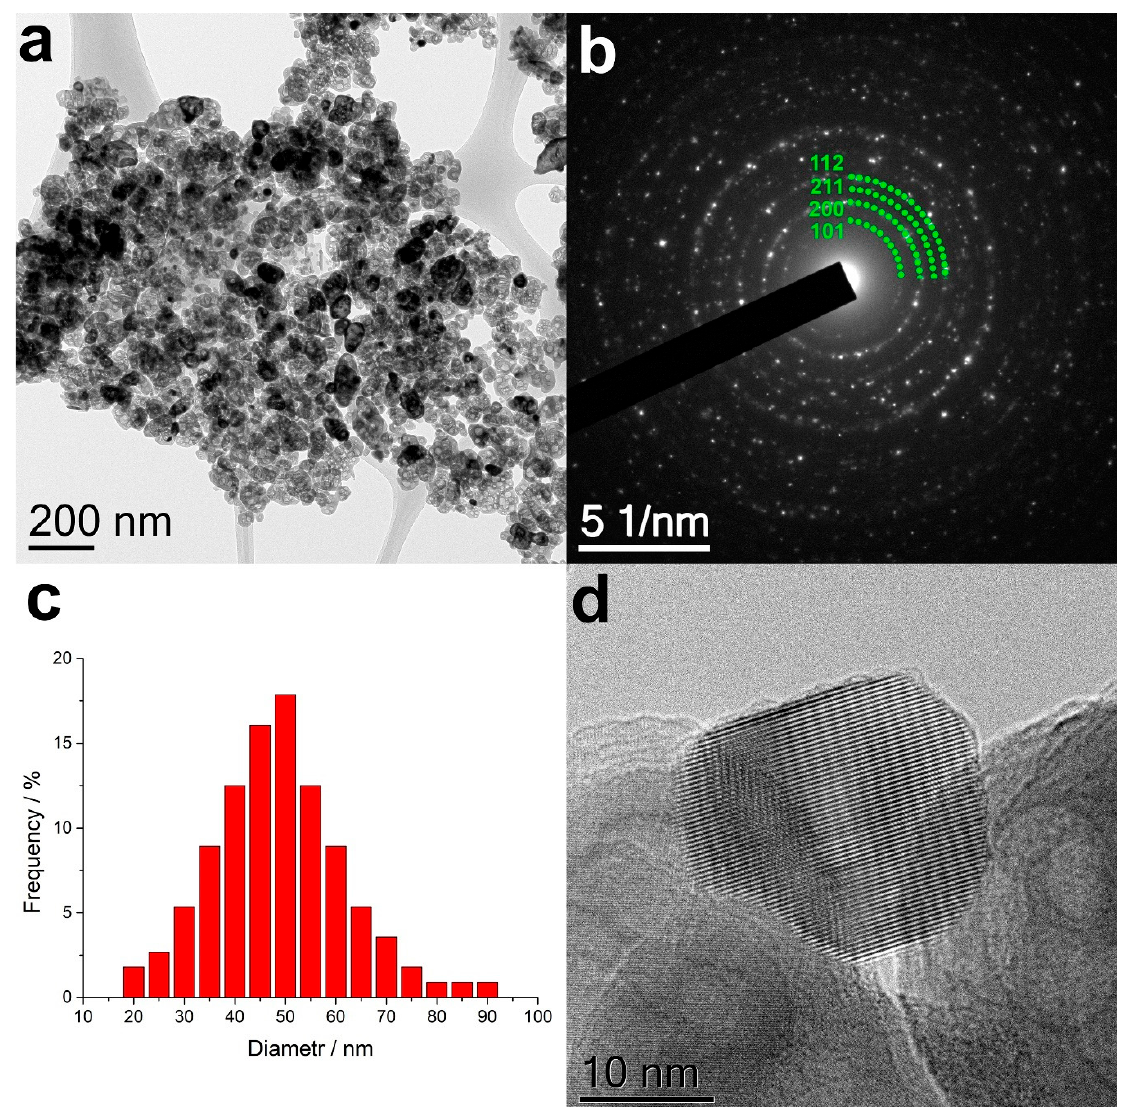
Figure 4. Results of TEM studies of YPO 4 :Gd phosphate powder: ( a ) bright field image of the pow- der, ( b ) electron diffraction pattern, ( c ) particle size distribution histogram, and ( d ) the crystal structure of the particles.